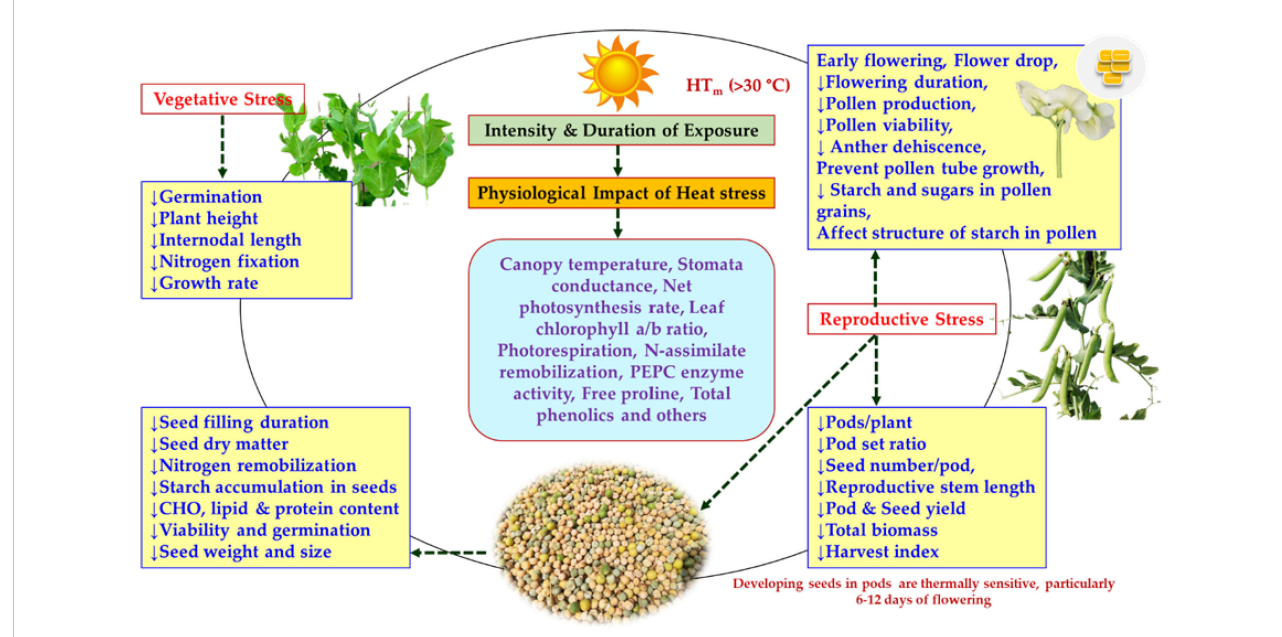
FIGURE 2 A diagram showing the physiological impact of HS in Pisum (Guilioni et al., 2003; Haldimann and Feller, 2005; Vijaylaxmi, 2013; Jiang et al., 2015; Larmure and Munier-Jolain, 2019; Mohapatra et al., 2020; Tafesse et al., 2020; Lamichaney et al., 2021).